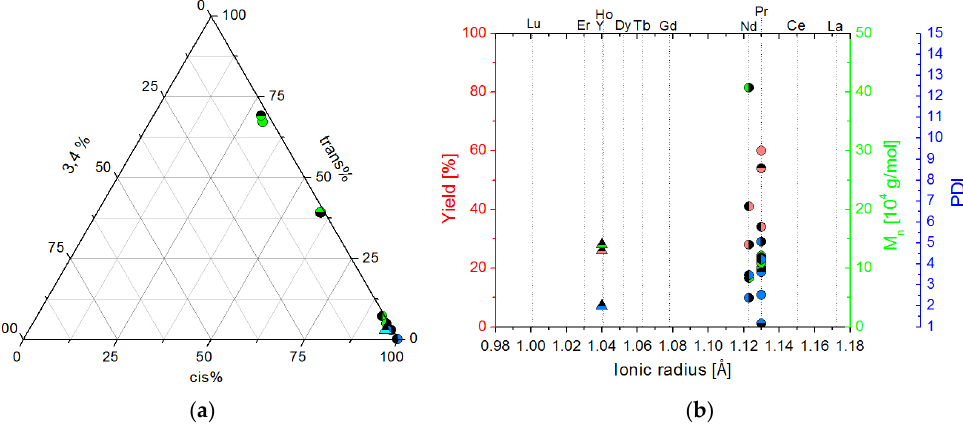
Figure 7. Overview on 1,3 ‐ butadiene polymerization data. In both panels, the black parts of the marks represent the cocatalyst applied: none: A , top: B , bottom: C , right: D and left E ( A = [Ph 3 C][B(C 6 F 5 ) 4 ], B = [PhNMe 2 H][B(C 6 F 5 ) 4 ], C = B(C 6 F 5 ) 3 , D = Me 2 AlCl, E = Et 2 AlCl). Results for the addition of 1 equiv. of cocatalyst per aluminate precatalyst are shown by circles, 2 equiv. by triangles. ( a ): ternary diagram representing the microstructure of the polybutadienes obtained from homoleptic lanthanide tetramethylaluminates. Precatalysts 2 Ln (Ln = Pr, Nd, Y) are color ‐ coded as follows: green (Pr), blue (Nd), cyan (Y). ( b ): overview chart representing the chain properties and yield of the polybutadienes. Rare ‐ earth metal precatalysts 2 Ln are shown in the order of increasing ionic radius ( x ‐ axis); the corresponding data are shown referring to three different y ‐ axes: red (yield), green ( M n ), blue (PDI).